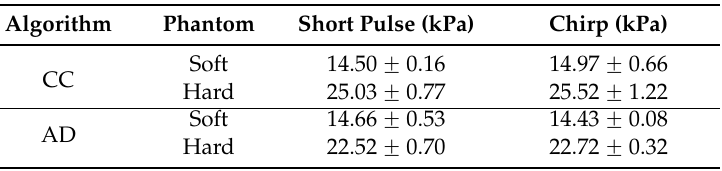
Table 4. Young’s modulus of phantom.